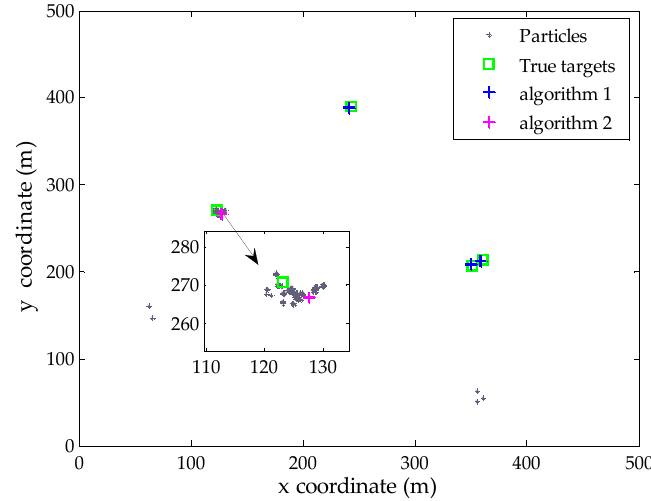
Figure 3. The modified estimate result and selected particles corresponding to undetected target.